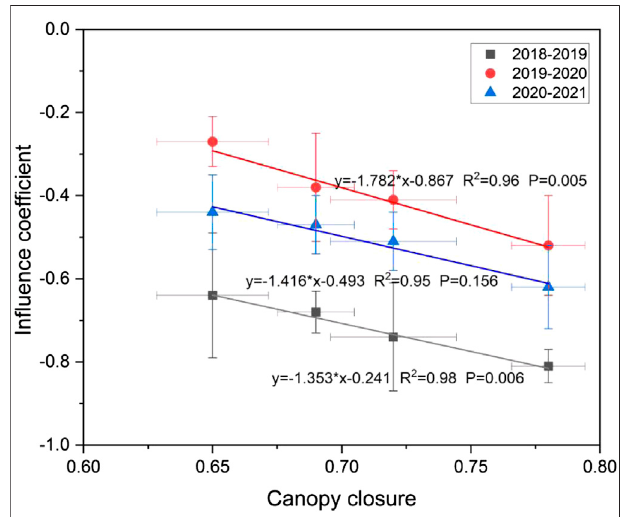
FIGURE 11 | Relationship between forest in fl uence effect ( E ) on snow processes and canopy closure ( θ ). Points of different colors and shapes represent different